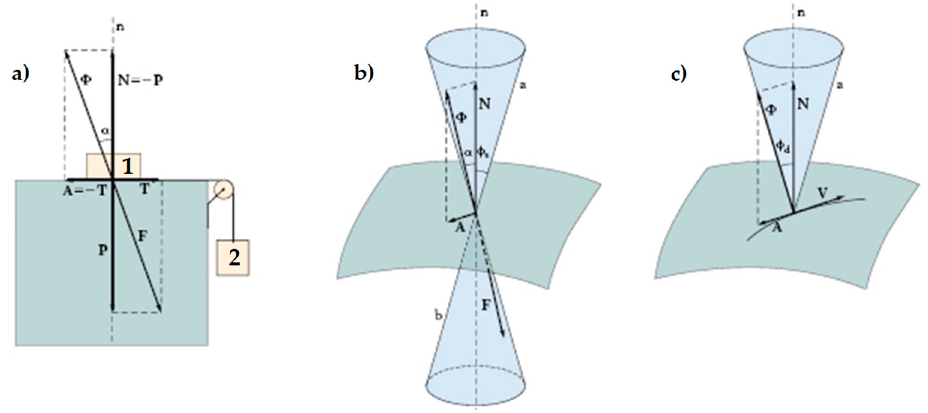
Figure 19. Friction forces in static and dynamic conditions: ( a ) forces at the interface between a body at rest (body 1) and its support body, ( b ) cone of static friction, and ( c ) cone of kinetic friction.